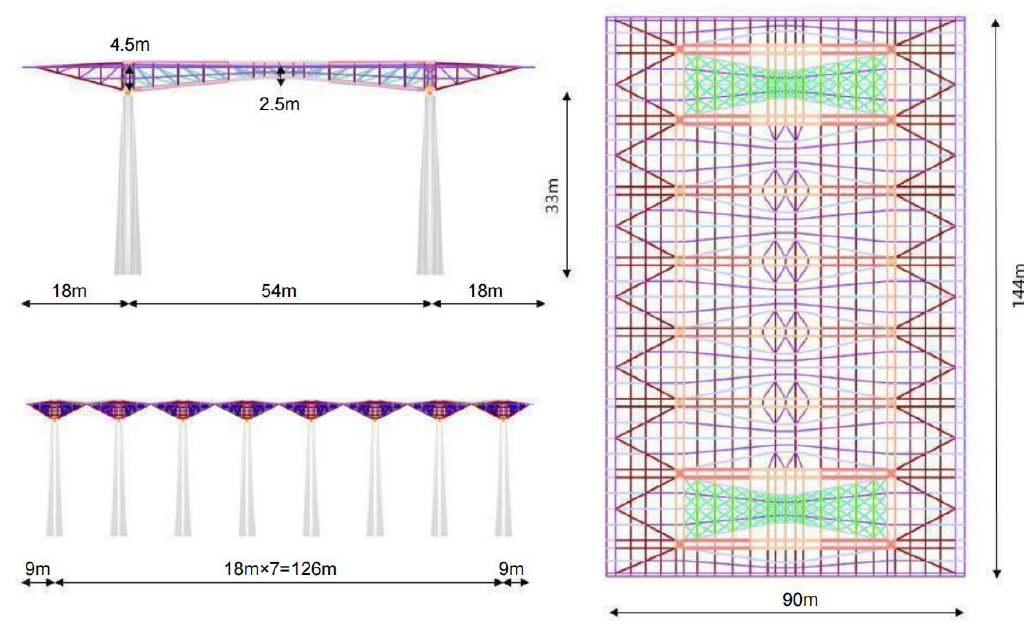
Figure 1. Architectural plan.